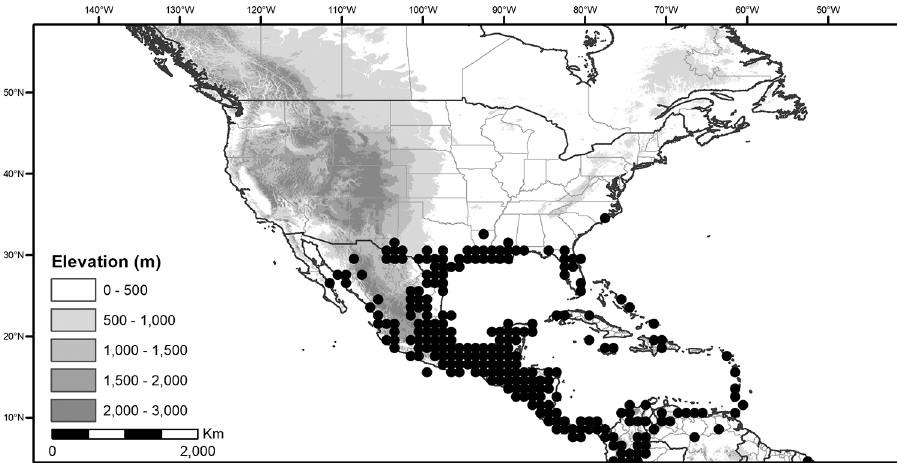
Figure 29. Distribution of Solanum nigrescens M.Martens & Galeotti (points in northern South America included to show continuous